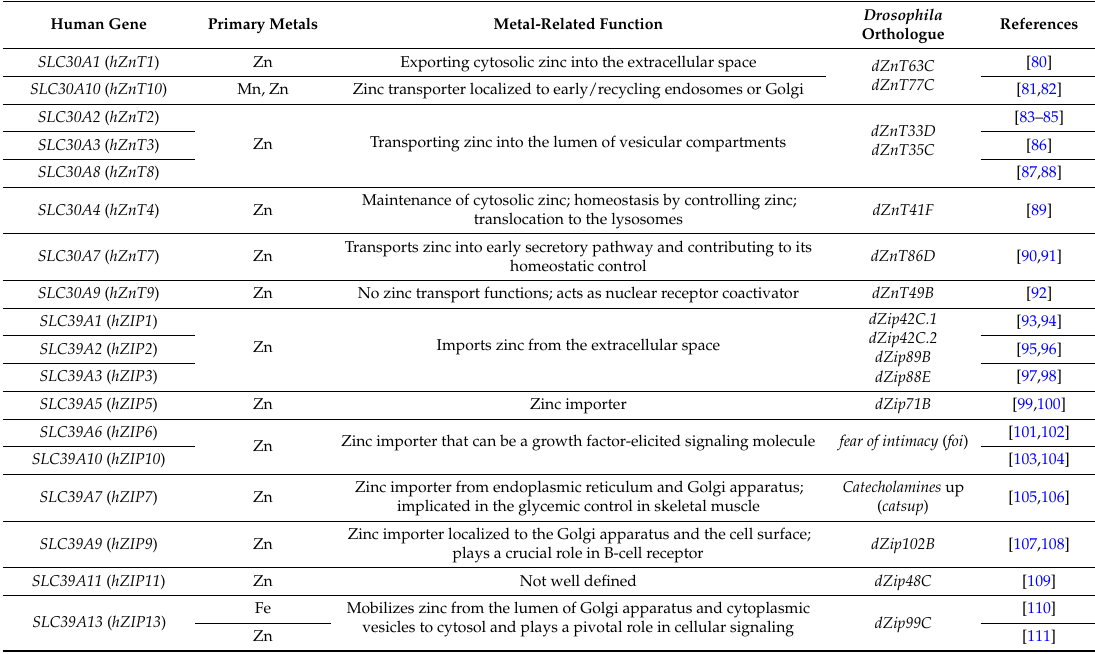
Gene symbols for human genes are indicated according to the Human Genome Organization Gene Nomenclature Committee (HGNC) (Available online: http://www.genenames.org). An alias is also indicated for them.